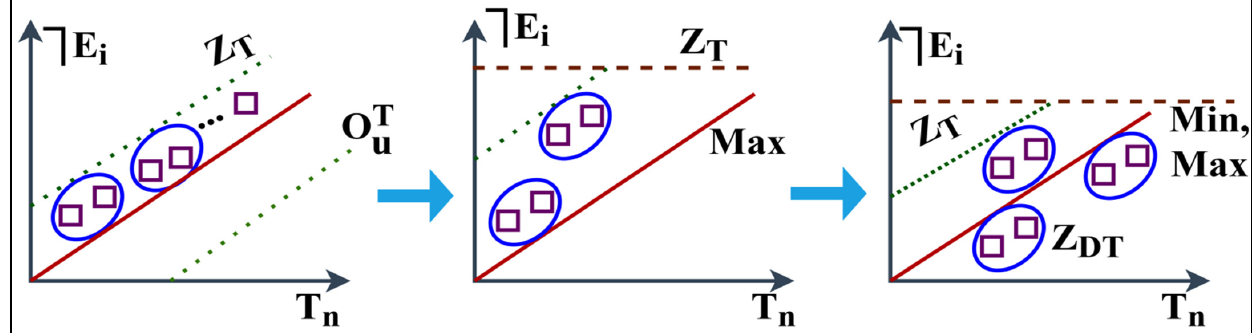
Figure 4. Classification